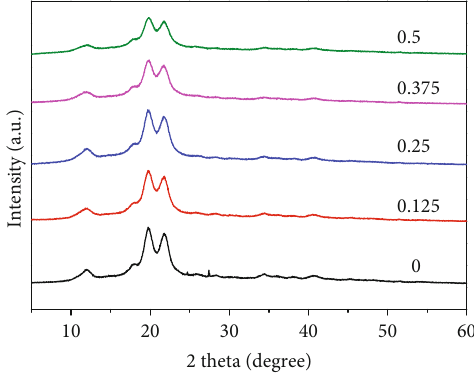
Figure 3: XRD spectra of OWPF with di ff erent degrees of